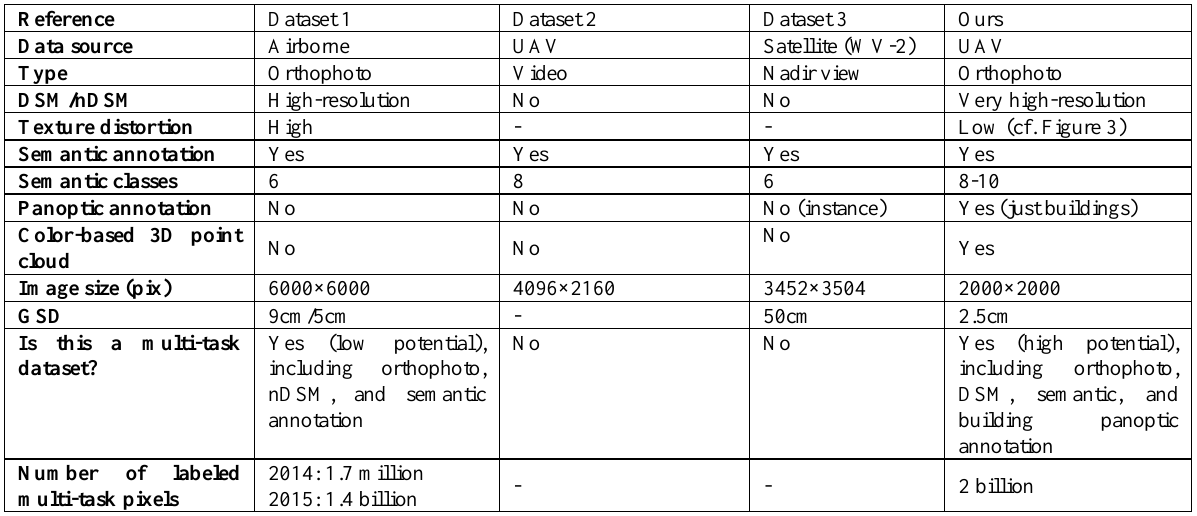
Table 1. List of the previous datasets and the proposed dataset for 2D/3D urban scene analysis